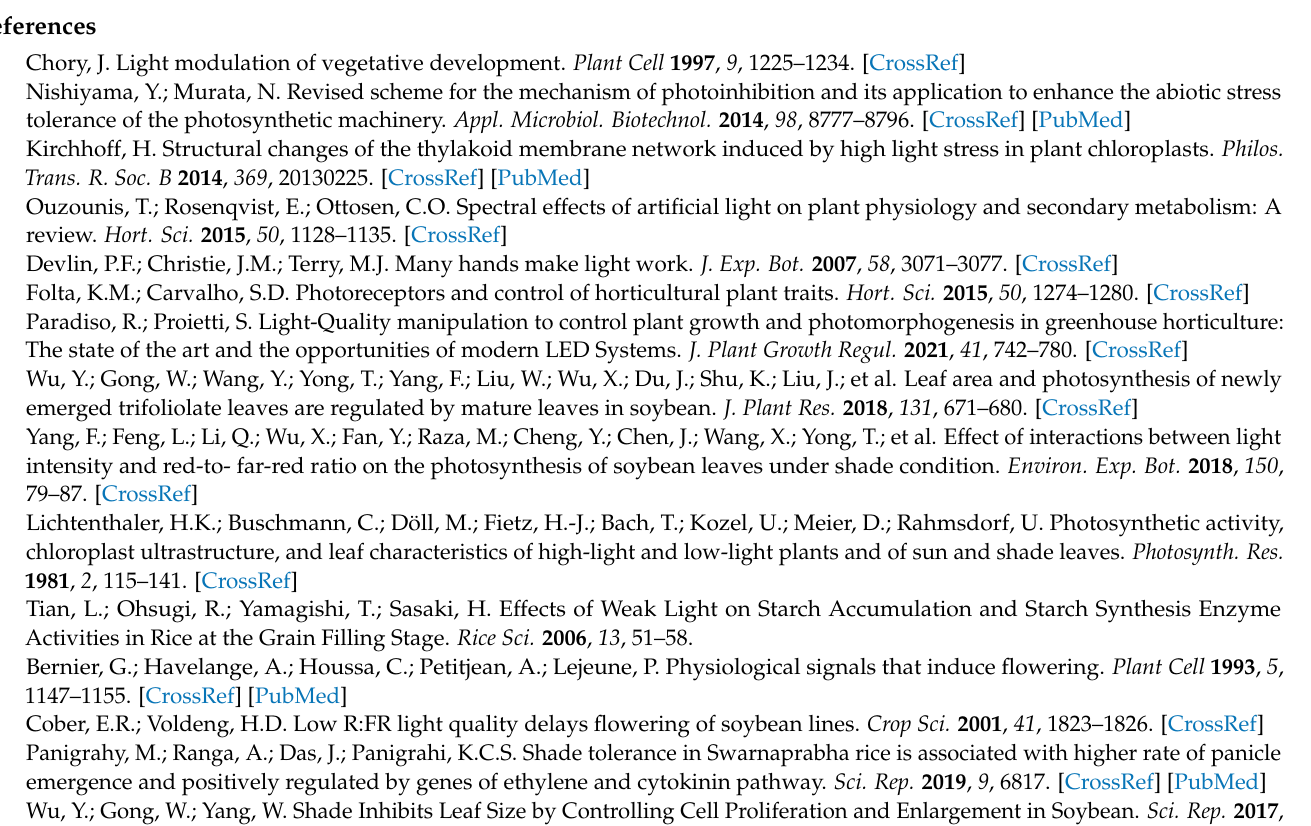
Error bars are ± SD of the average of three qRT-PCR replicates. Table S1 (a–h). List of novel and known miRNAs identified through miRNA NGS data, predicted by miRDeep2 for eight small RNA libraries. Table S2 (a–j). List of differentially expressed miRNAs identified through a comparative analysis between the samples. Table S3. List of miRNAs and target gene primers used in this